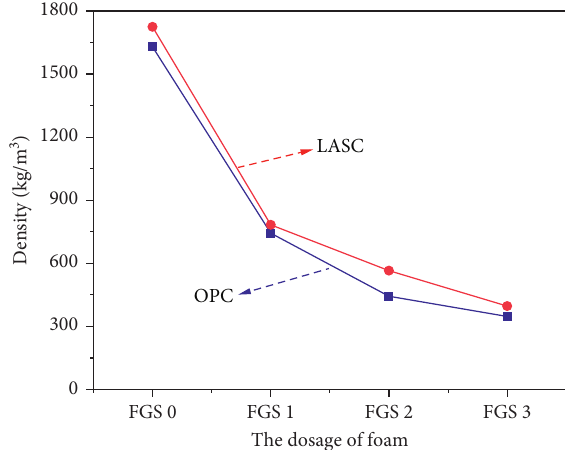
Figure 10: Initial setting time and fluidity of filling materials under different foaming dosage.